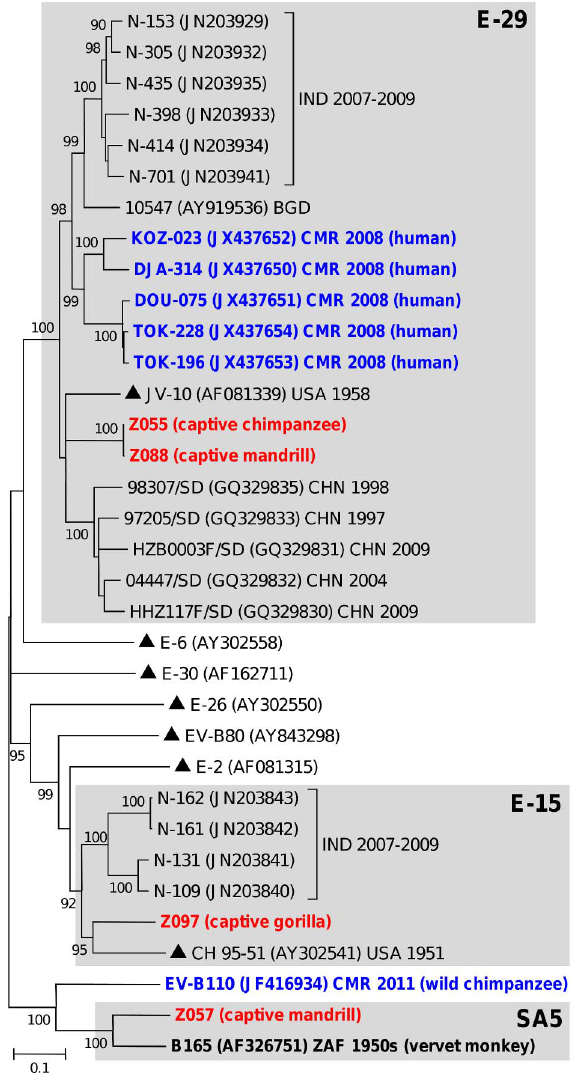
Figure 3. Phylogenetic relationships among Enterovirus B strains from human and non-human primates. The NJ tree is based on the alignment of the full-length VP1 sequences. Studied viruses from non-human primates are highlighted in bold red with the host names specified in brackets. Other human and simian viruses detected in Cameroon are in bold blue. The year and country of isolation are indicated for some viruses (BGD, Bangladesh; CHN, China; CMR, Cameroon; IND, India; USA, United States of America; ZAF, South Africa). Prototype strains are indicated by triangles ( m ). Scale is shown at the bottom as substitutions per site. Viral isolates belonging to enterovirus species commented in the text are gathered in grey-shaded